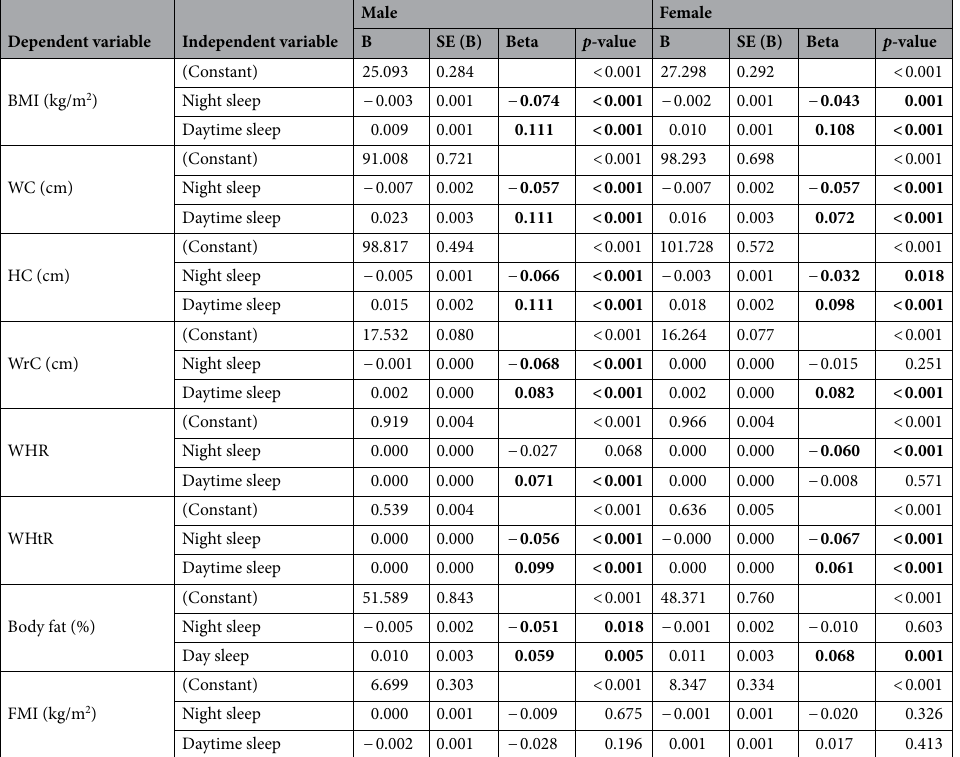
Table 2. Linear regression model of anthropometric data, body fat percentage, and fat mass index with night and daytime sleep hour duration as continuous variables in both gender. Beta: Standardized regression coefficients (calculated as b i × S Xi /S Y ). BMI body mass index, WC waist circumferences, HC hip circumferences, WrC wrist circumferences, WHR waist to hip ratio, WHtR waist to height ratio, FMI fat mass index. Bold values are less than 0.05 and are statistically